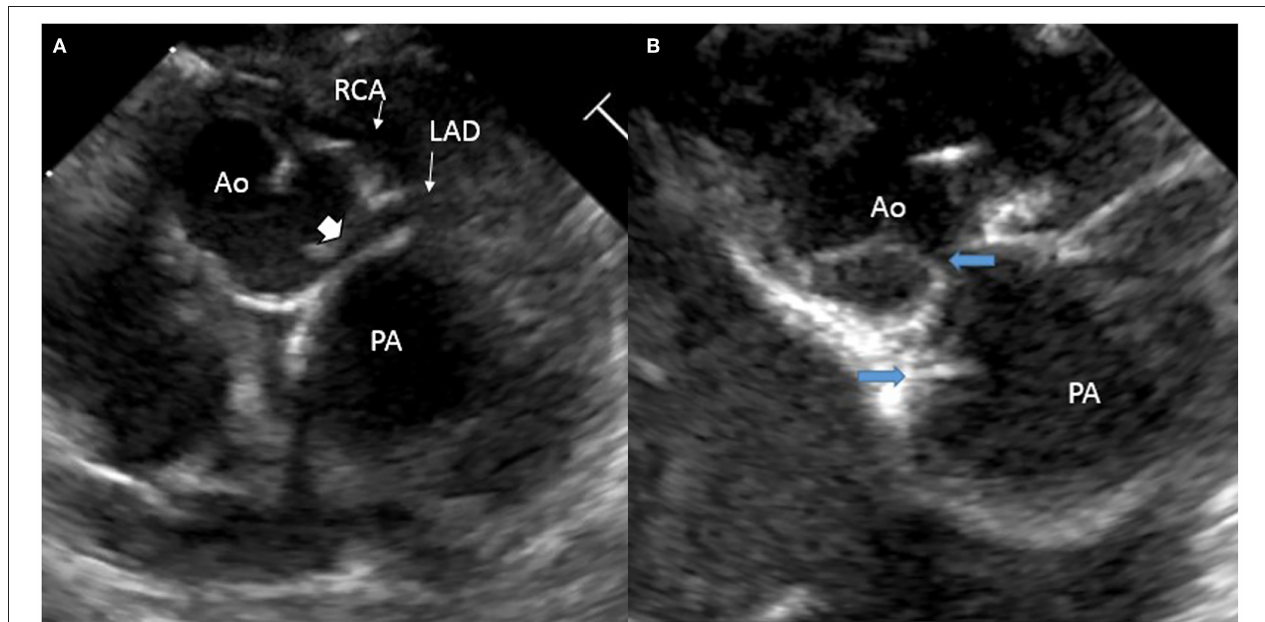
FIGURE 1 | Echocardiogram images: (A) intramural course (solid arrowhead) of the main segment of the coronary artery that divides into the right coronary artery (RCA) and the left anterior descending (LAD) from the posterior sinus (Sinus 1); (B) commissural malalignment as indicated by the blue